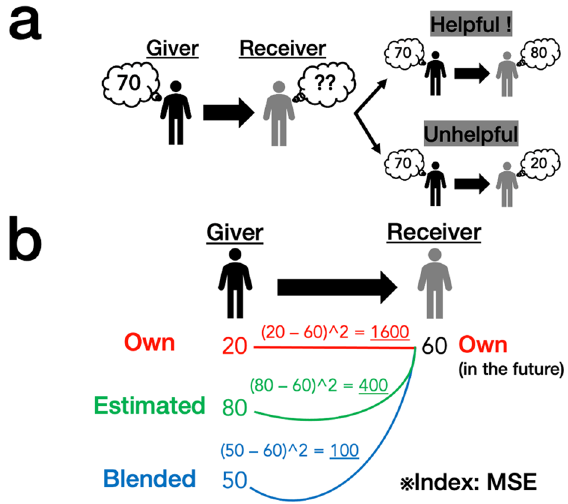
Figure 1. Illustration of the analysis. ( a ) Definition of the helpfulness of a Giver’s opinion. When the Giver’s opinion can accurately predict a Receiver’s (future) preference (the right upper column), we define the opinion as ‘helpful’ for the Receiver. Conversely, when the Giver’s opinion inaccurately determines the Receiver’s future choice (the right lower column), we consider the opinion as ‘not helpful (unhelpful)’. ( b ) Computation of the efficacy (helpfulness) of a Giver’s opinion. We set the Giver’s Own, Estimated, and Blended opinions, after which we calculated the MSE (Mean Squared Error) between each of the Giver’s opinions and a Receiver’s future satisfaction (the Receiver’s Own opinion). A smaller MSE indicates that the Giver’s opinion is more helpful. Through the analysis, all participants except the Giver became Receivers. Additionally, we computed the MSE for all participants including the